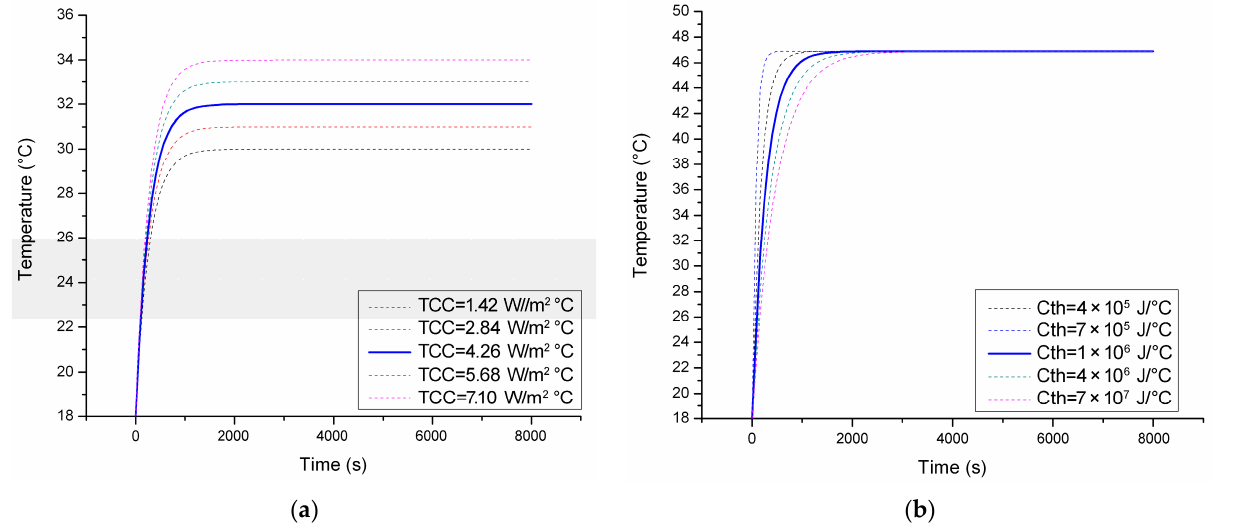
Figure 11. ( a ) Matching the TCC and ( b ) C th of the model to the behavior of the physical system.